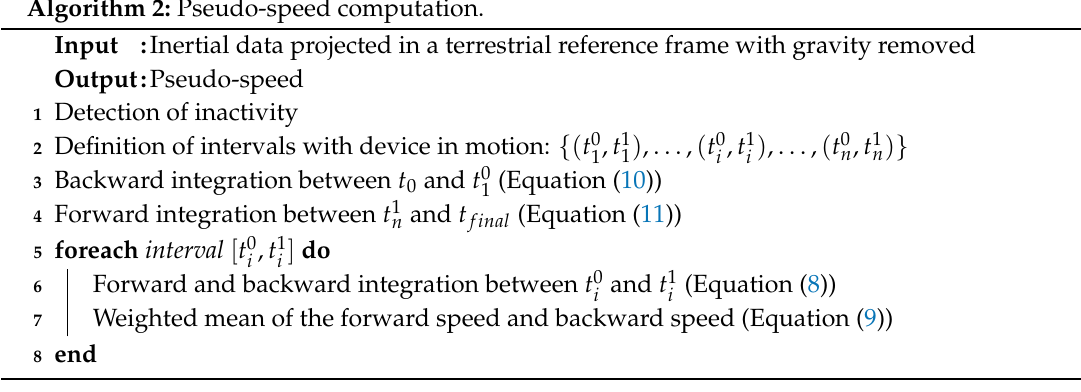
Algorithm 2: Pseudo-speed